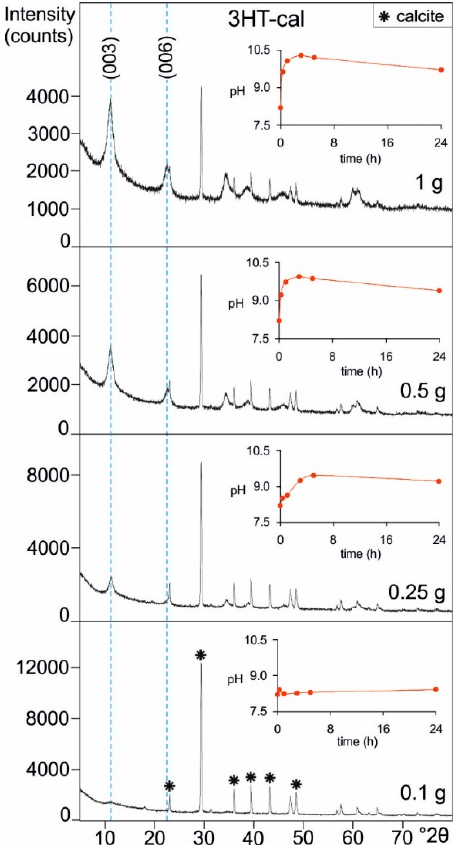
Figure 5. XRD patterns of 3HT-cal recovered after the sorption experiments with the slag drainage SU1 performed with different amounts of 3HT-cal (0.1, 0.25, 0.5, 1 g). On the upper right side of each XRD pattern the pH of solution as a function of time during each experiment is reported. The blue dashed lines indicate the basal reflection of layered double hydroxides (LDHs) formed after the sorption experiments.